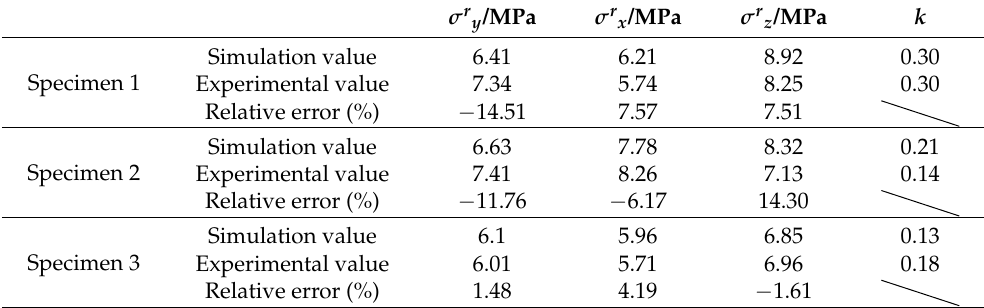
Figure 21. Simulation stress–strain results and experimental measurements of Specimen 3 ( a ) in the in-plane direction along the y -coordinate, ( b ) in the in-plane direction along the x -coordinate, and ( c ) in the out-of-plane direction. Table 6. Comparison of simulation results and experimental